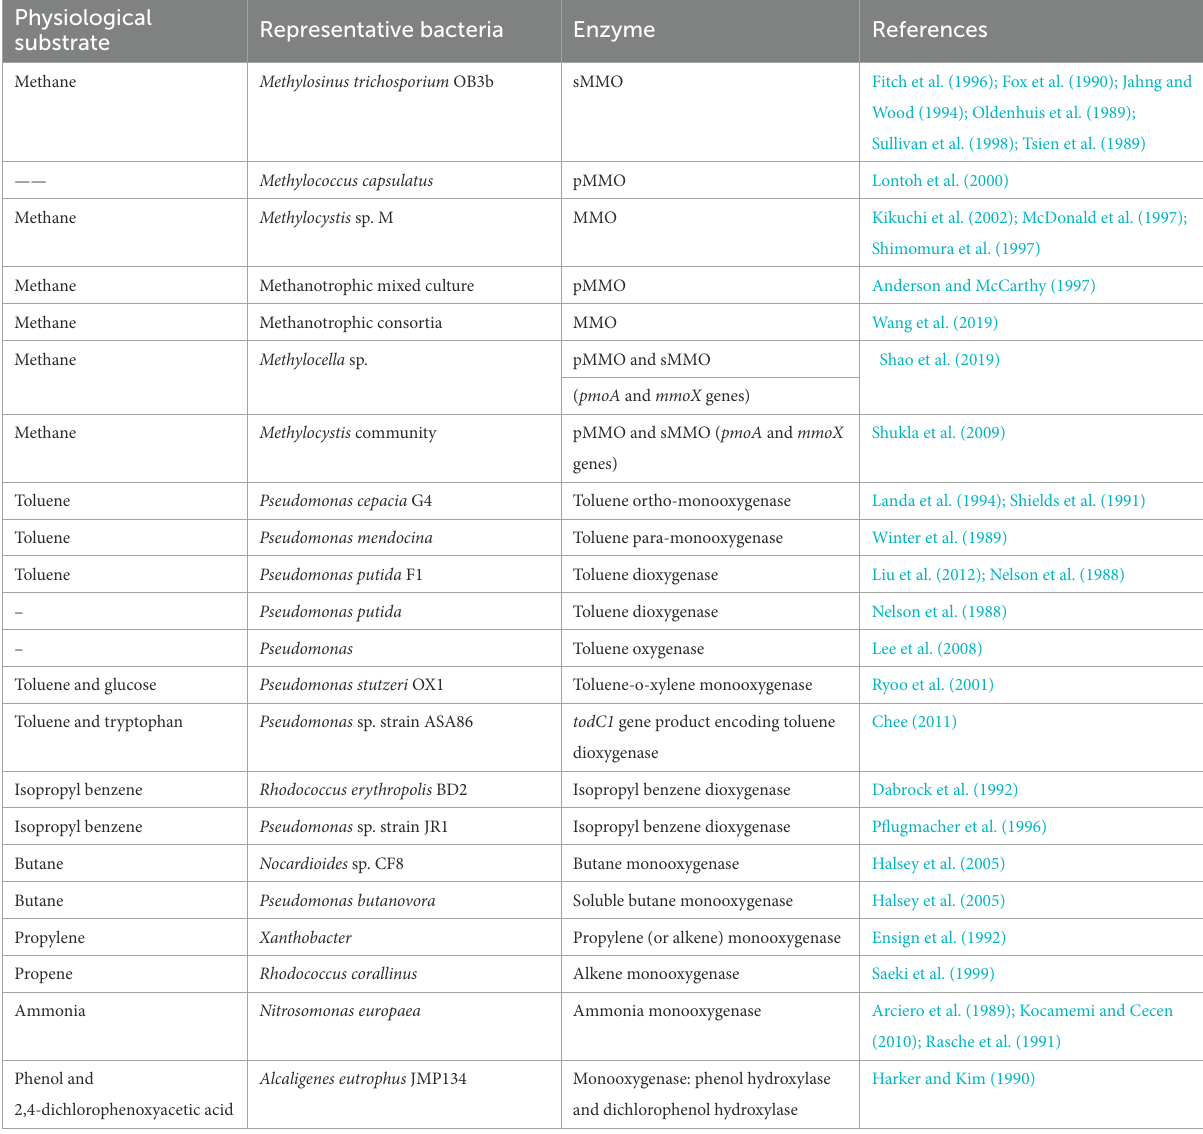
TABLE 5 Physiological substrates, bacteria, and enzymes involved in TCE